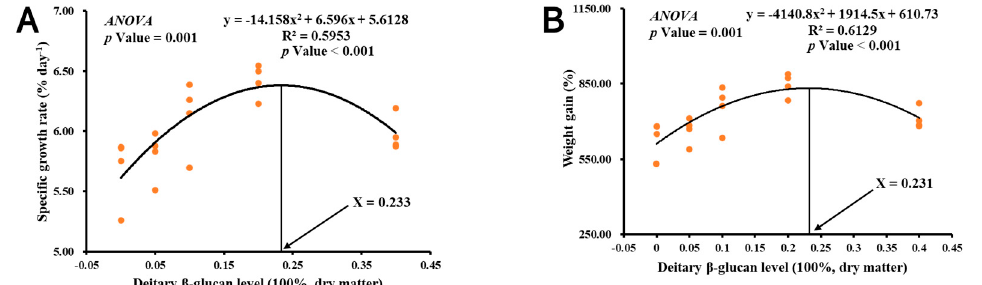
Figure 1. Relationships of ( A ) specific growth rate and ( B ) weight gain with dietary β -glucan levels based on second − order polynomial regression analysis of Juvenile L. vannamei , where Xopt repre- sents the dietary β -glucan level ( n = 4).